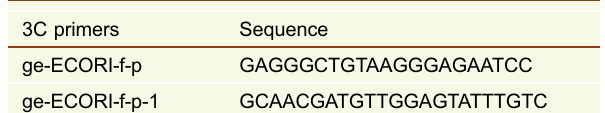
cells and higher mammals. (A) Integrated analysis of the activity of GE in human IPSC lines. Insulators (red lines) and interactions (green lines) of human iPSCs involving the enhancer and promoter of GLUT1 are displayed at bottom. Binding pro fi les for OCT4 and H3K27ac of IPSCs are displayed at the top. (B) GE is active in human iPSCs, ectoderm, endoderm, neural progenitor cells (NPCs), mesenchymal stem cells (MSCs), and certain human cancer cells as indicated by the epigenetic marker (H3K27ac) labeled in blue. (C) Fast minimum evolution tree was used to reveal the evolutionary relationship of GE. (D) GE is active in mouse ESCs. The epigenetic signature (H3K27ac and H3K4me1) of GE (blue box) and the binding pro fi les of SON are conserved in mouse ESCs. The predicted interaction sites between the enhancer and promoter of the Glut1 gene in mouse ESCs are indicated by green boxes. The conserved region of the mouse and human GE is indicated with a